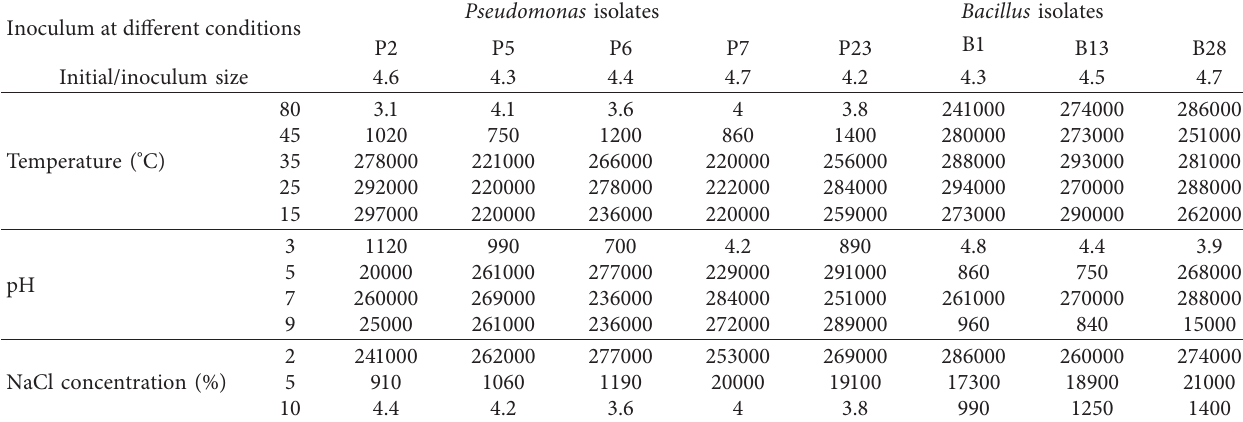
Table 3: Growth expressed as CFU/mL ( × 10 6 ) at different temperature, pH, and NaCl levels values. Inoculum at different